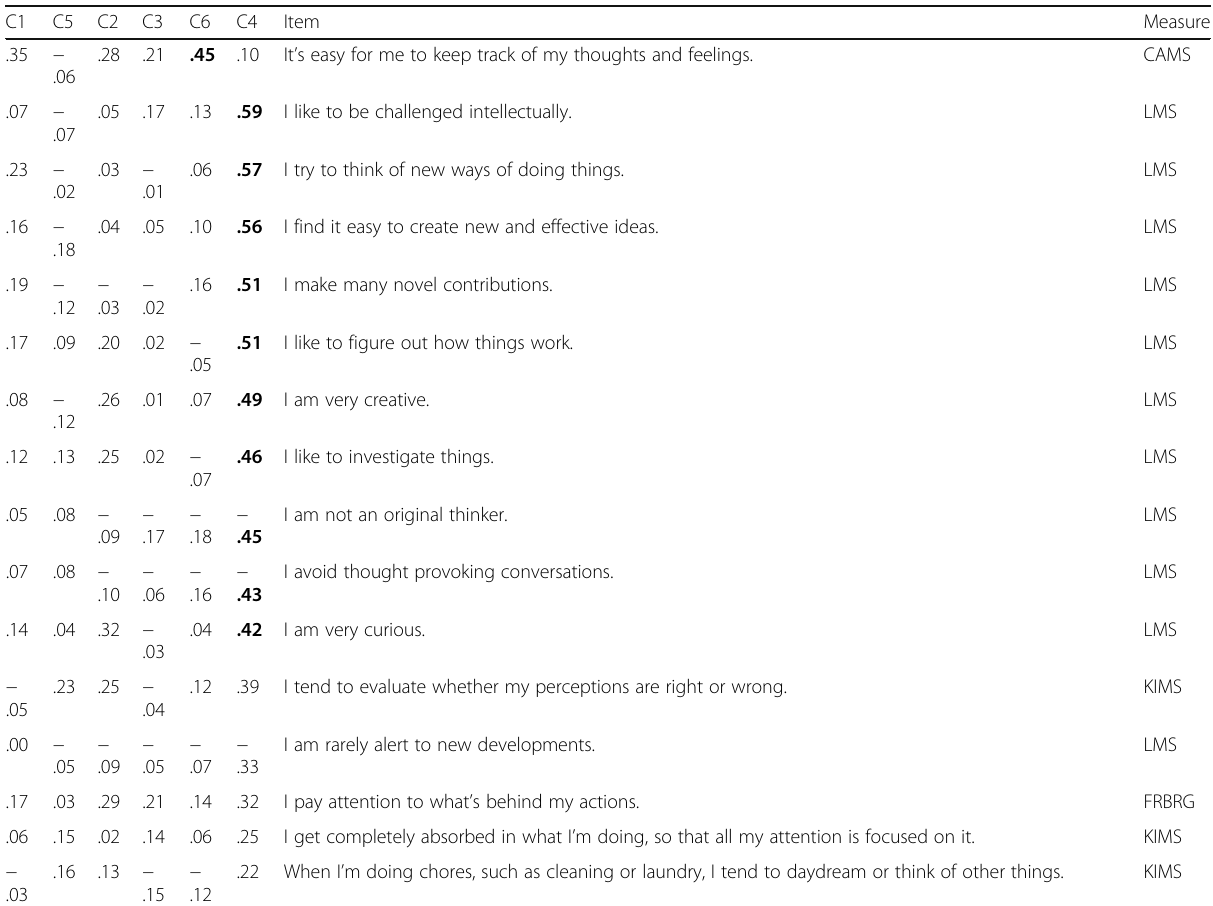
Table 4 Component loadings of the mindfulness items on the final six components